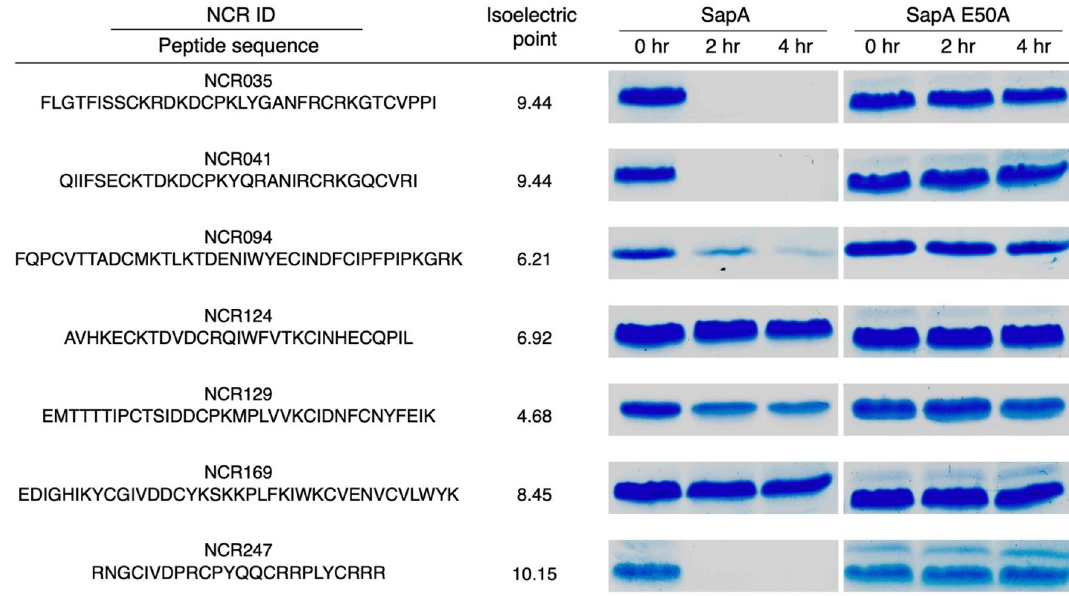
Figure 3. Degradation of NCR peptides by SapA in vitro. SapA and a catalytically inactive version (SapA E50A) were each incubated with several different NCR peptides individually and analyzed via tricine gel at 0, 2, and 4 h. Images of representative experiments are shown above though each peptide was tested for degradation in at least three separate experiments with equivalent results. Full-length gels are presented in Supplementary Fig. S3.